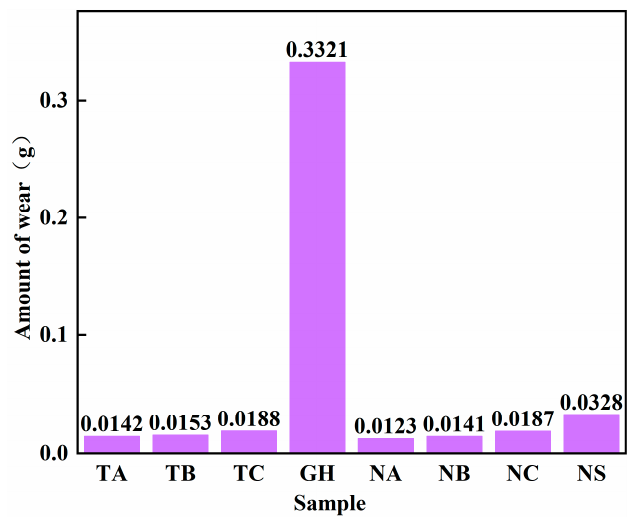
Figure 12. Experimental wear loss in each group.